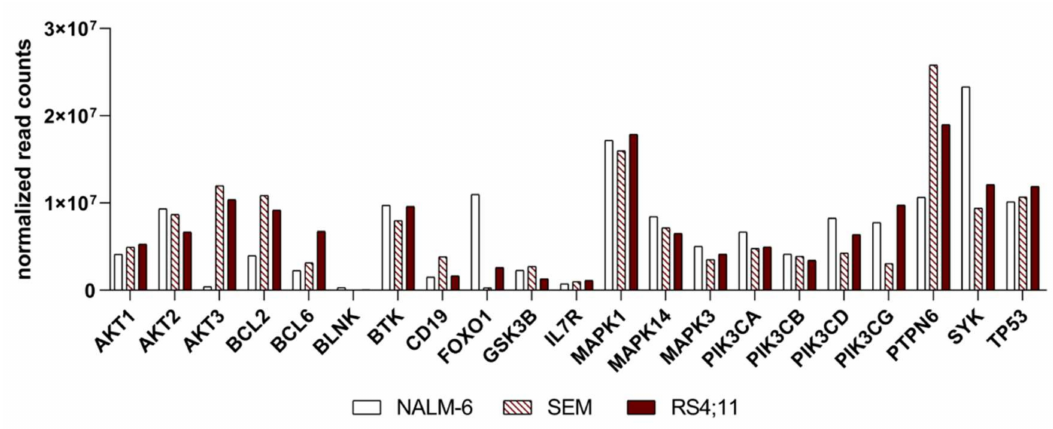
Figure 2. Basal expression of the B-cell receptor and PI3K/AKT pathway genes. Representation of the BCR and PI3K/AKT pathway key regulators in all B-ALL cell lines. Basal expression of selected essential BCR and PI3K/AKT pathway genes; targeted sequencing normalized read